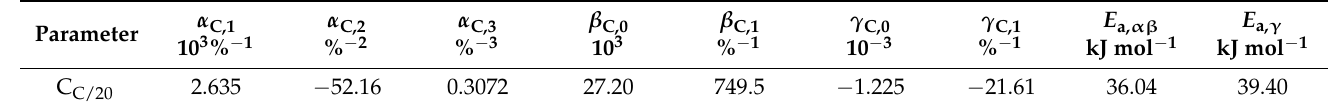
Table 3. The 4D fit model parameter for C C/20